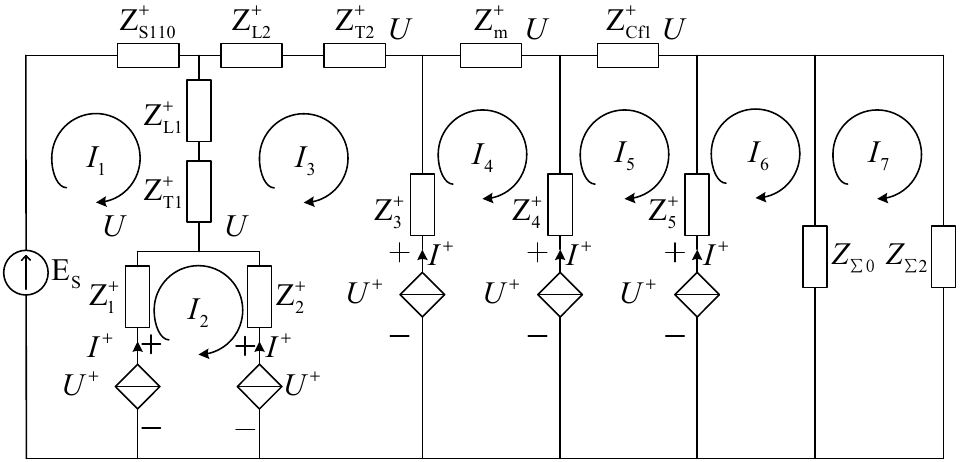
Figure 10. Complex sequence network of two-phase ground fault on the collector line in PVPS3.